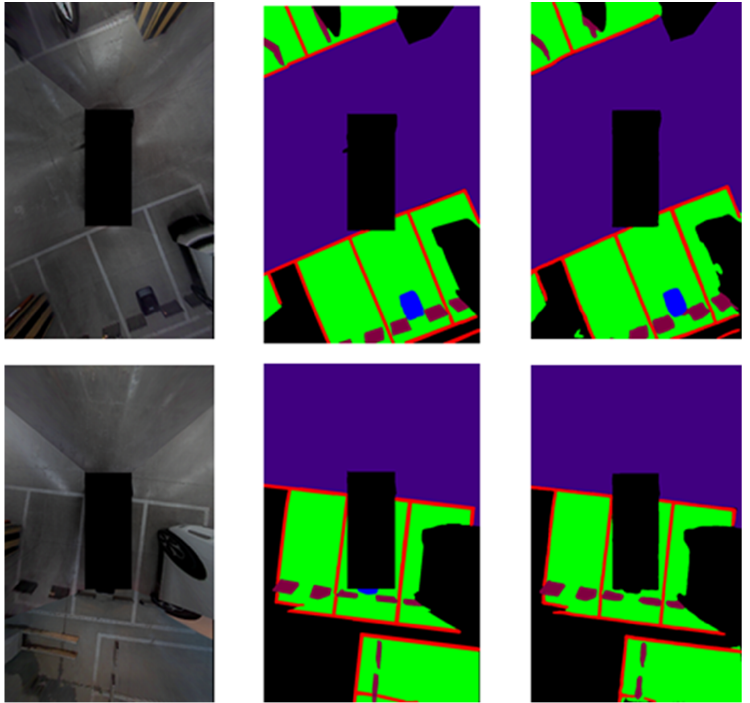
Figure 9. Indoor semantic segmentation detection results. Left: input; middle: ground truth; right: output.